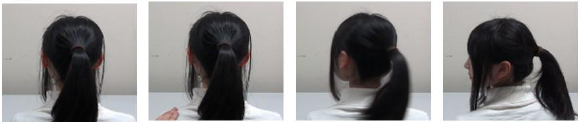
Figure 5. Video stimulus with a female model.